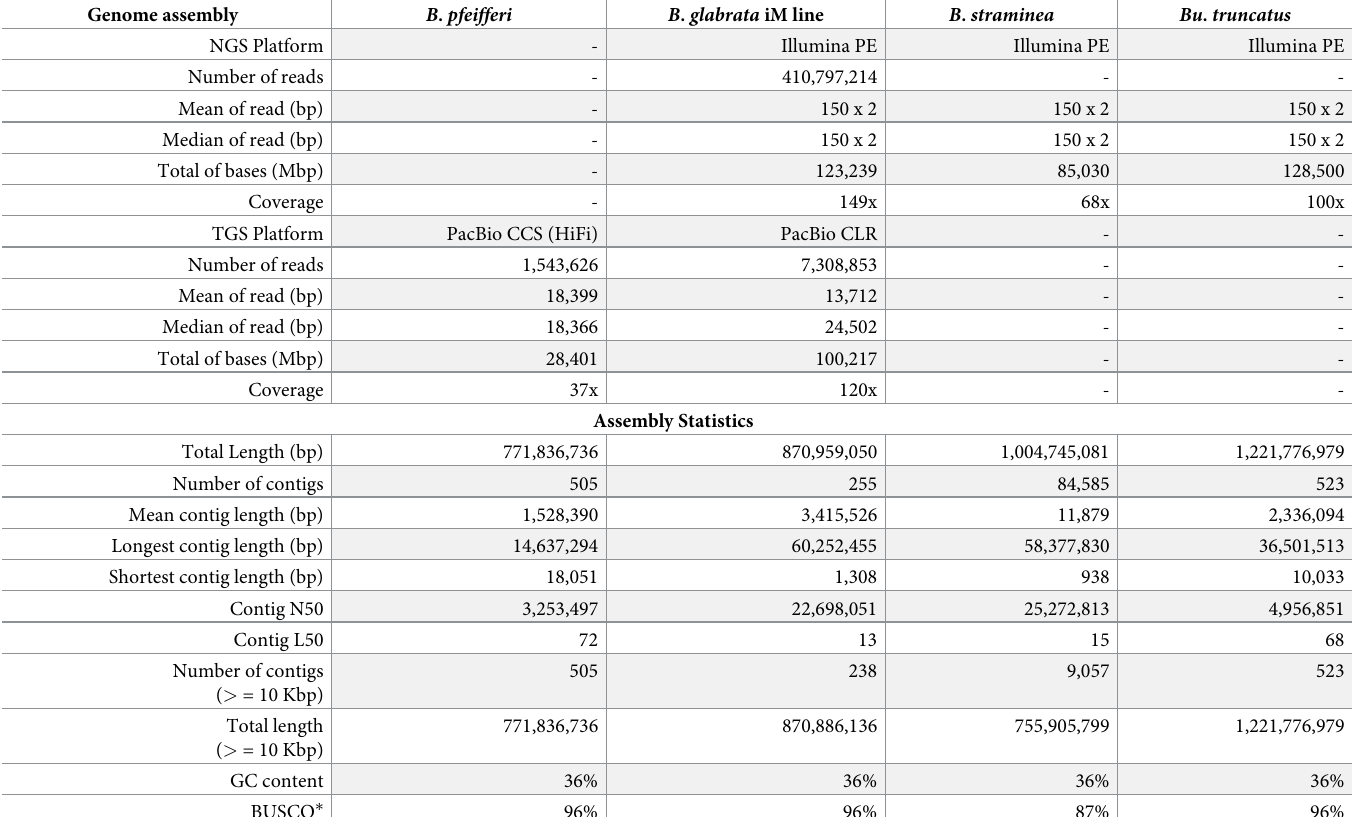
Table 2. Summary statistics of the genome assembly of B . pfeifferi and related snail genomes. Genome assembly